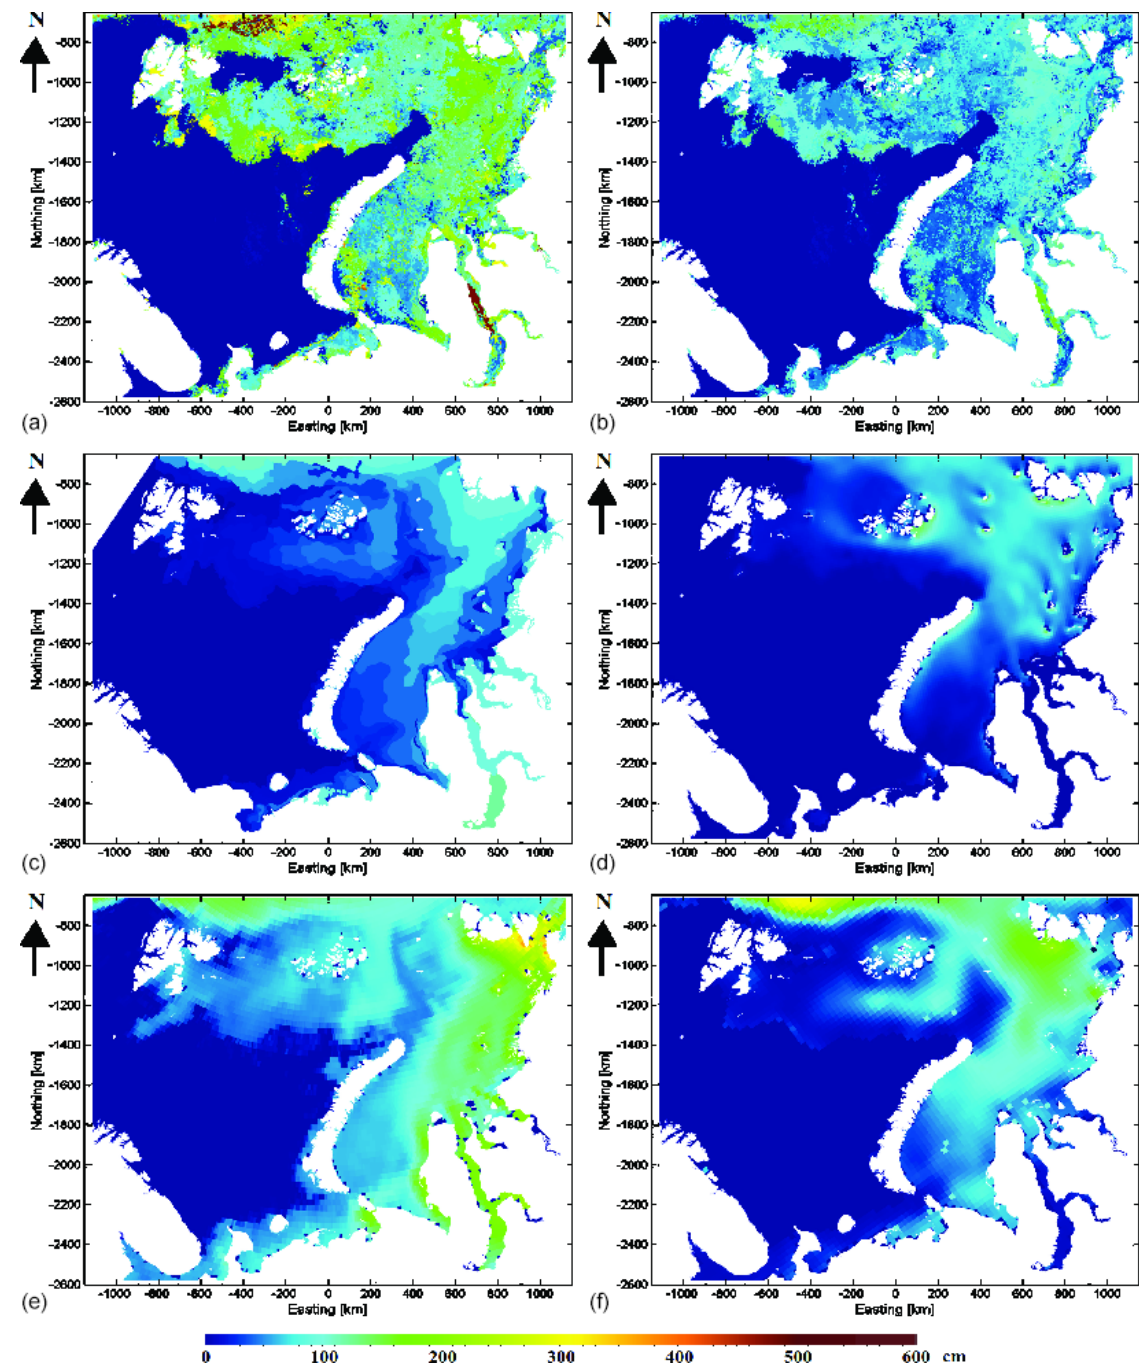
Figure 9. (a) CS2/S-1 SIT, (b) remapped CS2/S-1 SIT, (c) AARI ice chart SIT, (d) TOPAZ4 ice model reanalysis SIT, (e) ORAS5 model ice model SIT and (f) CS2/SMOS SIT for 21 February 2017.